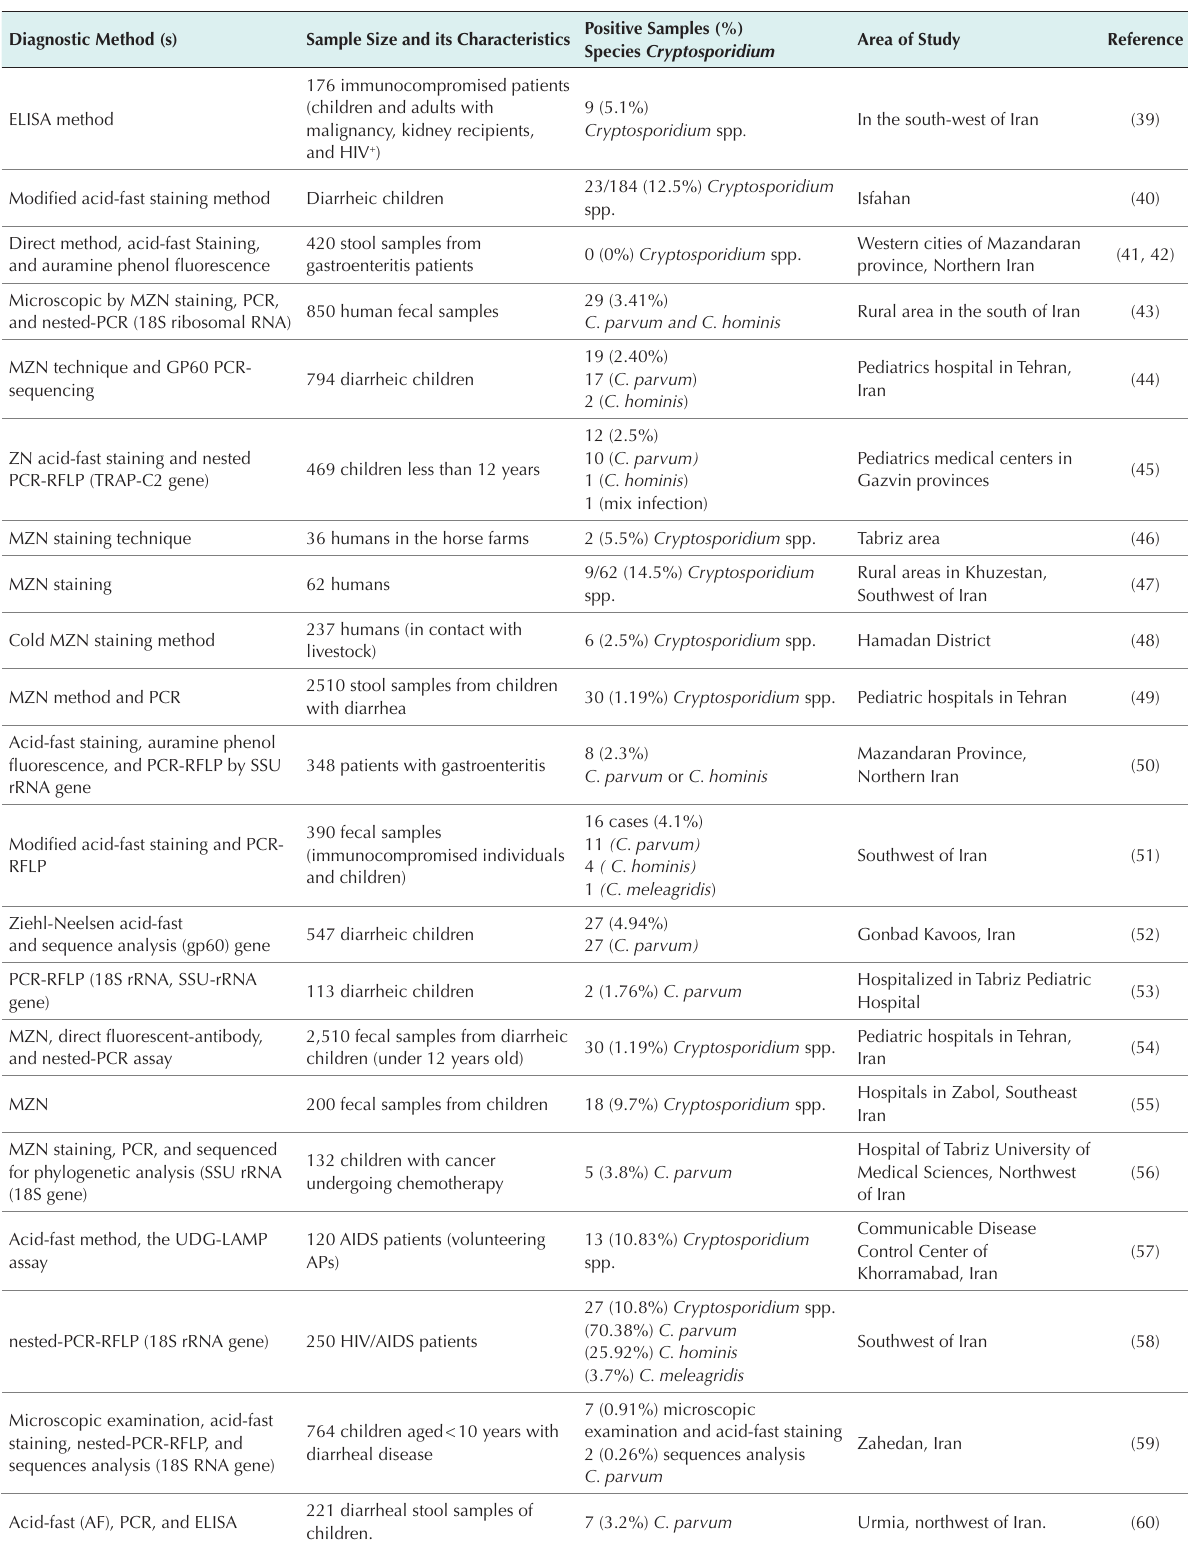
Table 1. Detection of Cryptosporidium spp. in Humans in Iran During 2010-2020 Diagnostic Method